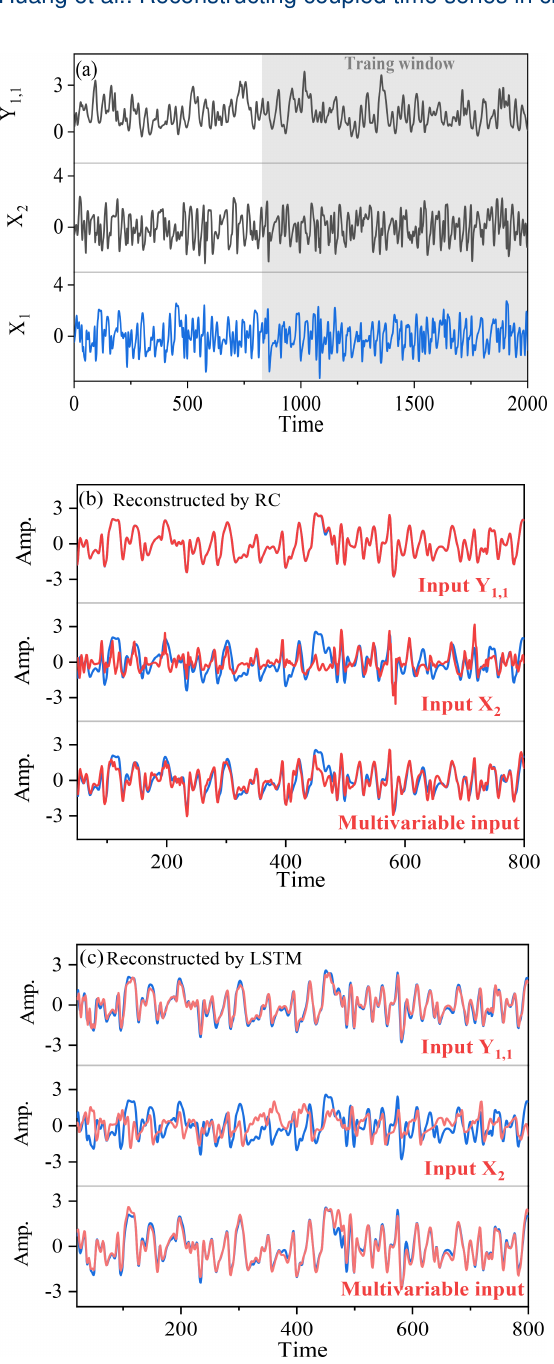
Figure 7. (a) The Y 1 , 1 time series (black), X 2 time series (black), and X 1 time series (blue) of the Lorenz 96 system. (b) Recon- structed by RC; when Y 1 , 1 , X 2 , and the multivariate are acting as the explanatory variables, the corresponding reconstructed X 1 time series (red) are shown, and blue lines denote the real X 1 time series. (c) Reconstructed by LSTM; when Y 1 , 1 , X 2 , and the multivariate (multiple variables: X 2 , X 17 , and X 18 ) are acting as the explana- tory variable, the corresponding reconstructed X 1 time series (red) are shown, and blue lines denote the real X 1 time